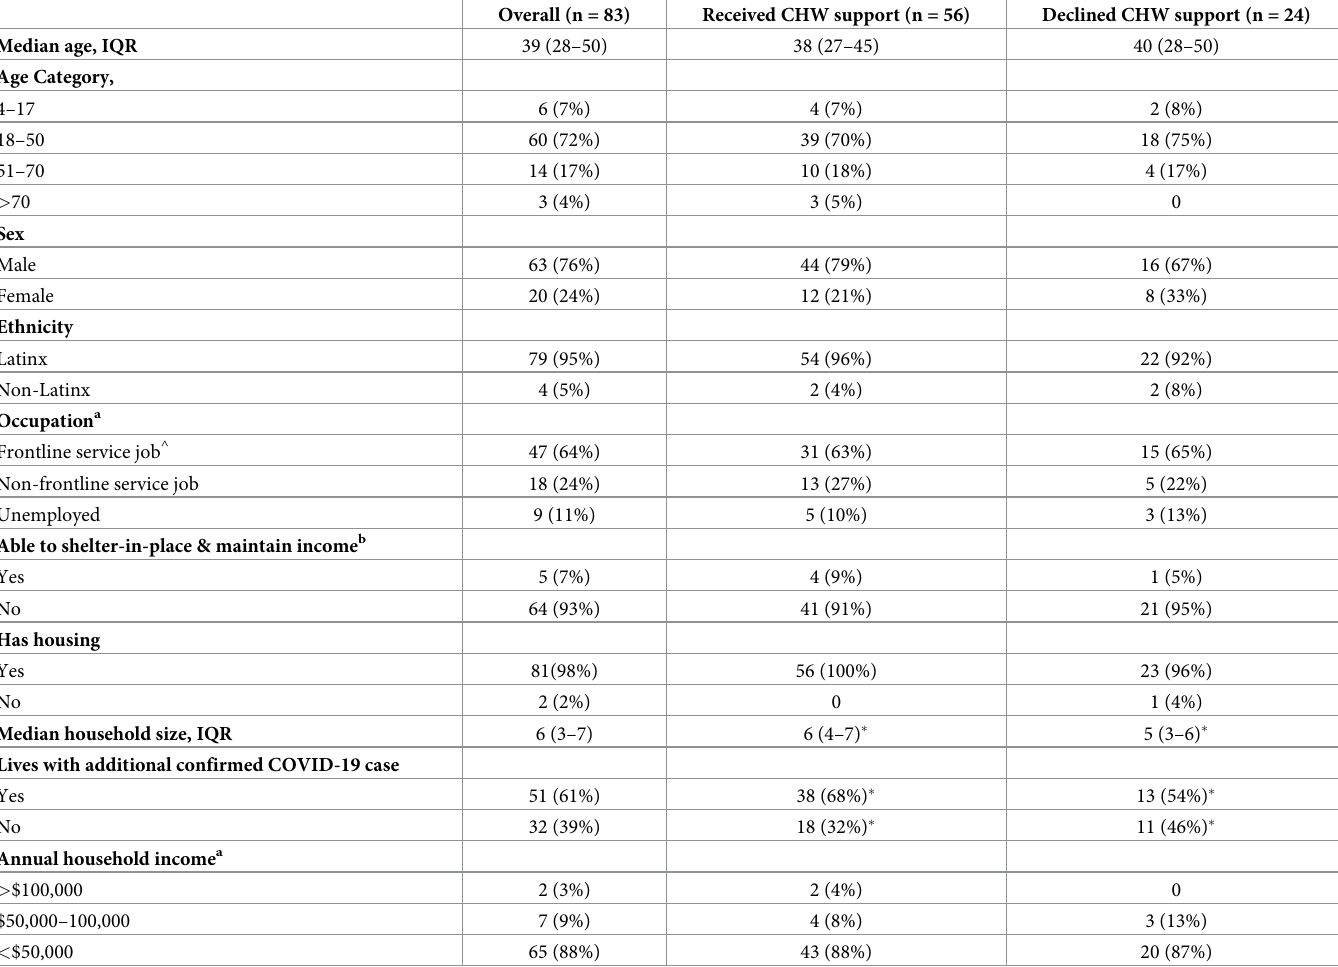
Table 3. Baseline demographics and socioeconomic characteristics and reach of the CHW support component of the T2C